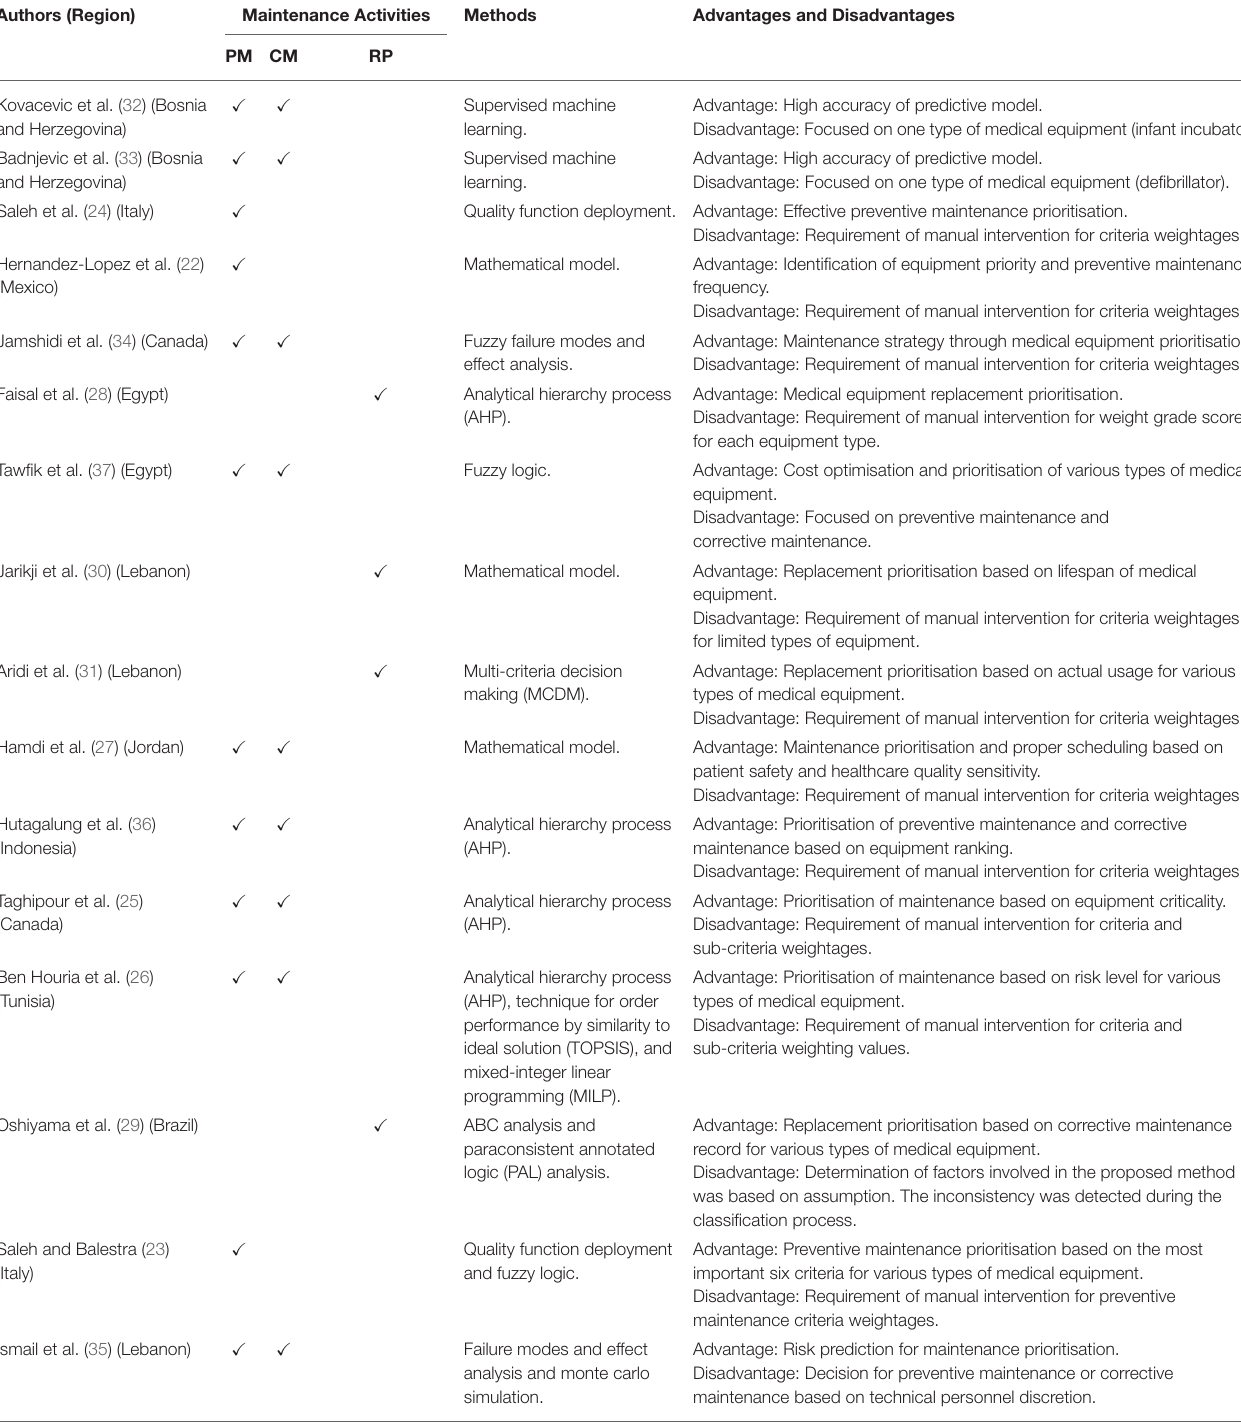
TABLE 1 | Summary of previous studies review. Authors